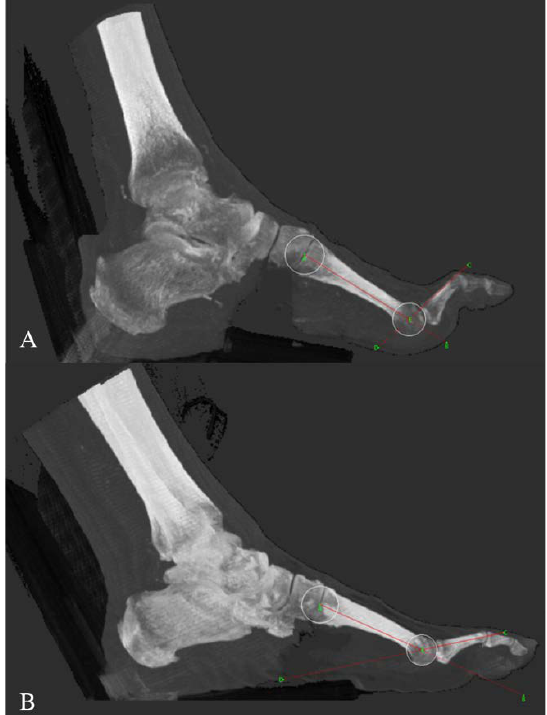
Figure 1. Representative CT scan images from individuals with severe ( A , bone mineral density = 295 HU, 2nd metatarsophalangeal joint angle = 74.6 degrees) and minimal ( B , bone mineral density = 489 HU, 2nd metatarsophalangeal joint angle = 36.1 degrees) metatarsophalangeal joint deformity. CT, computed tomography; HU, Hounsfield units.